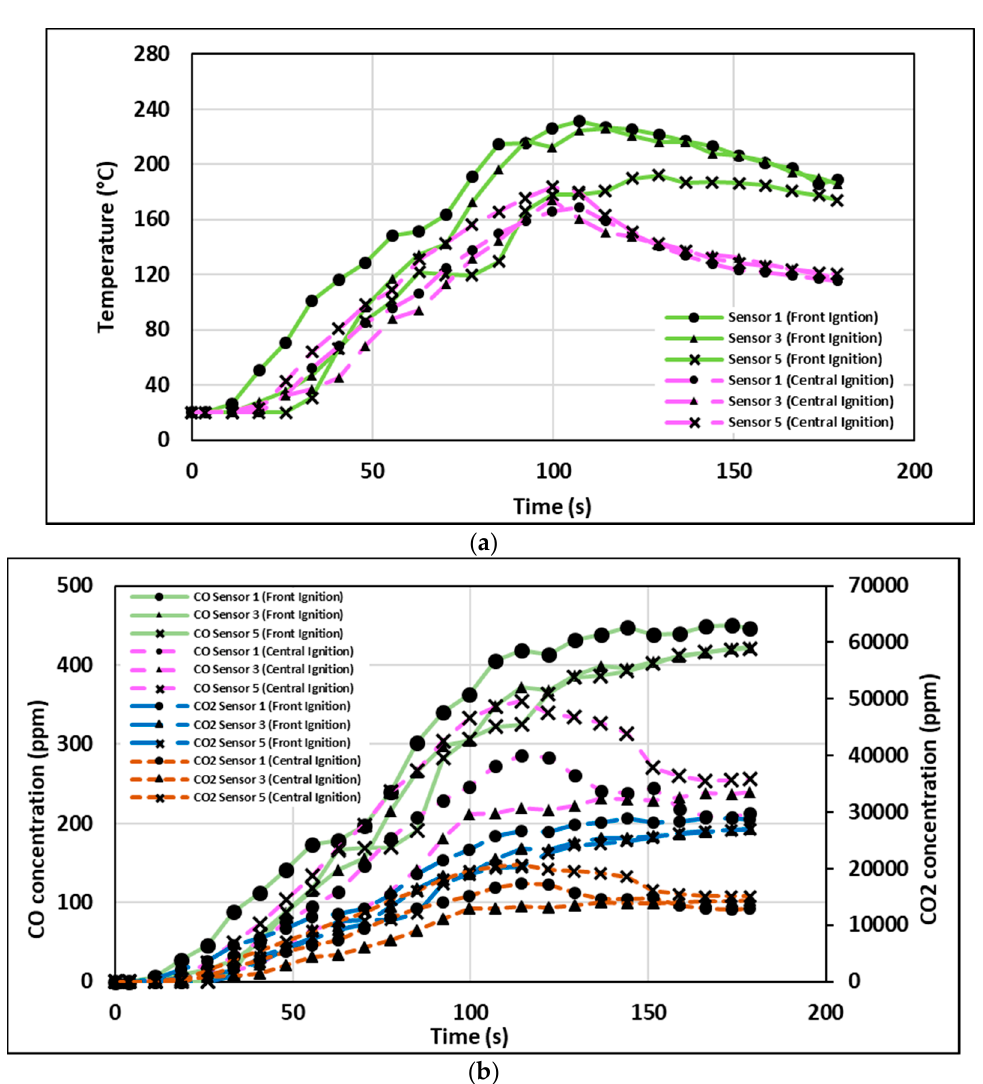
Figure 7. ( a ) Temperature profile comparison due to ignition position. ( b ) Carbon gases concentrations for different ignition positions.